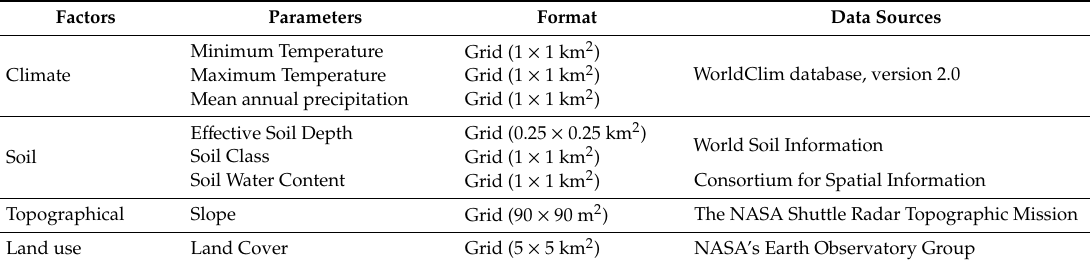
Table 1. The land cover and environmental